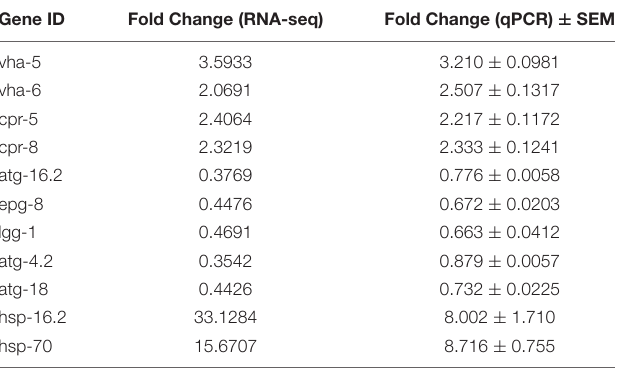
TABLE 1 | Differential gene expression verified by